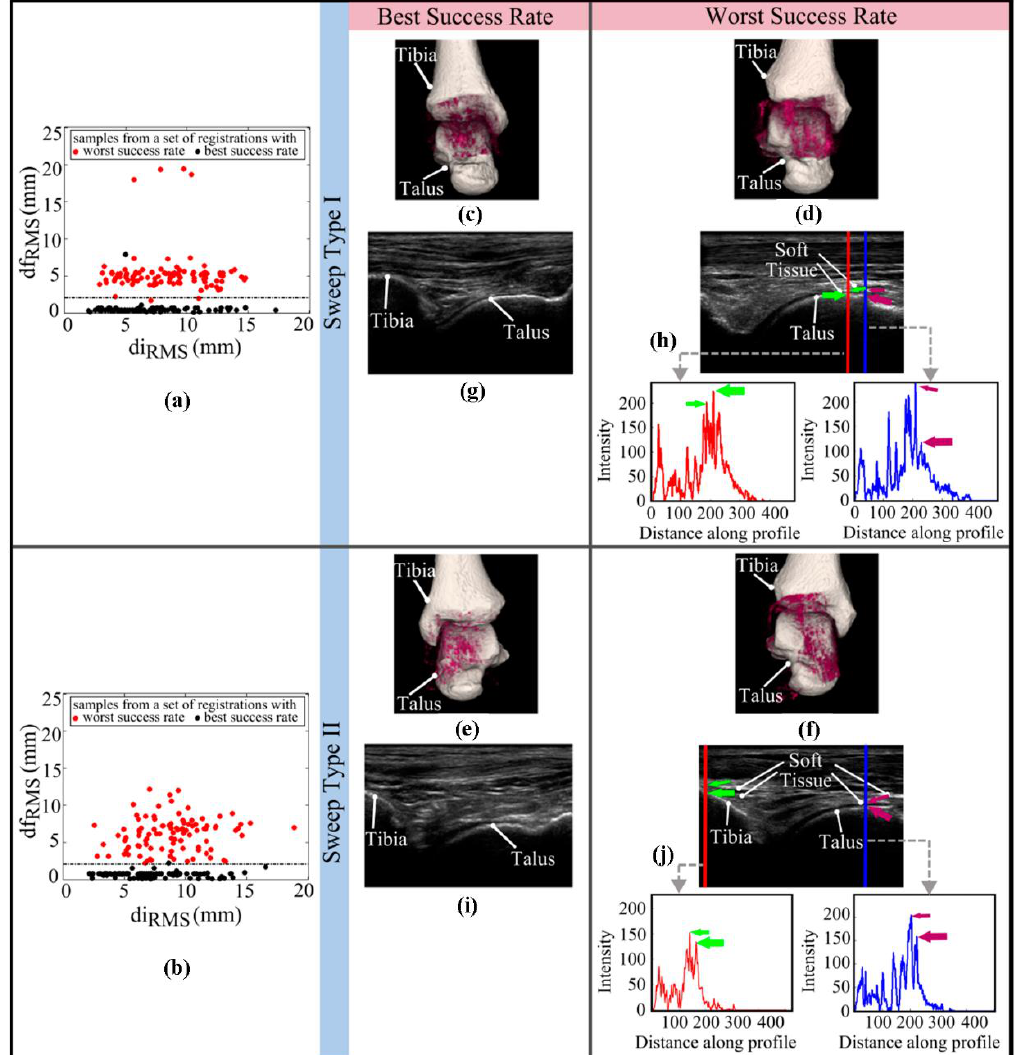
Figure 6. Plots of the df RMS values vs. the di RMS values calculated over 100 registrations are given for ( a ) the ‘Sweep Type I’ US sweeps ( b ) the ‘Sweep Type II’ US sweeps showing the best and worst success rate in Test I. Black ( n = 100) and red ( n = 100) dots in ( a ) are samples retrieved from a set of registrations performed for the ‘Sweep Type I’ US sweeps with the best and worst success rate, respectively. In a similar manner, those ( n black = 100 and n red = 100) in ( b ) are related to a set of registrations run for the ‘Sweep Type II’ US sweeps with the best and worst success rate. Visualizations of 3D bone response volumes of the ‘Sweep Type I’ US sweeps ( c ) with the best and ( d ) the worst success rate, and of the ‘Sweep Type II’ US sweeps ( e ) with the best and ( f ) the worst success rate in the Test I are shown. Original 2D slices taken from the US sweeps ( c – f ) are presented in a corresponding manner ( g – j ). The intensity profiles of the two vertical lines (i.e., intensity vs. distance along profile graphs shown in red and blue correspond to the lines drawn in red and blue, respectively) displayed in ( h ) and ( j ) indicate that the ridge-like edge feature corresponding to the expected bone boundary can be weaker than those related to the soft tissue interface. Thin and thick arrows shown in green and purple point to the ridge edge features linked, respectively, to soft tissue interface and bone boundary. The results of the clinical case in terms of the mean percentage of visible talar surface at the lateral, central, and medial part of the talus, are presented in Table 3. On average, 51 ± 3% of the talar surface of each maximum plantar flexed cadaveric ankle could be imaged using US (Table